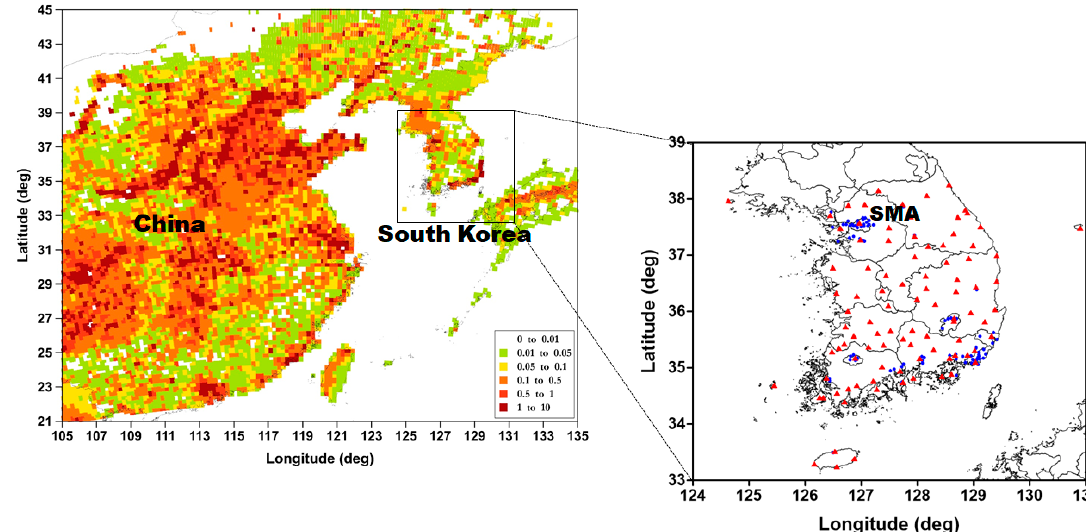
Figure 1. The modeling domain and SO 2 emissions (moles/s) distribution ( left ), and the location map of South Korea ( right ). The right panel shows the locations of meteorological (red triangles) and air quality (blue circles) observation sites. “SMA” denotes Seoul Metropolitan Area.